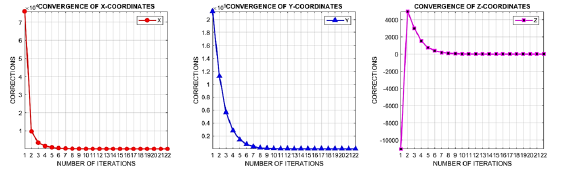
Figure 8. a). The MMS trajectory shown on the map in coloured dots. b) Illustration of a GCP measured from four oblique aerial images and its location in a selected MMS